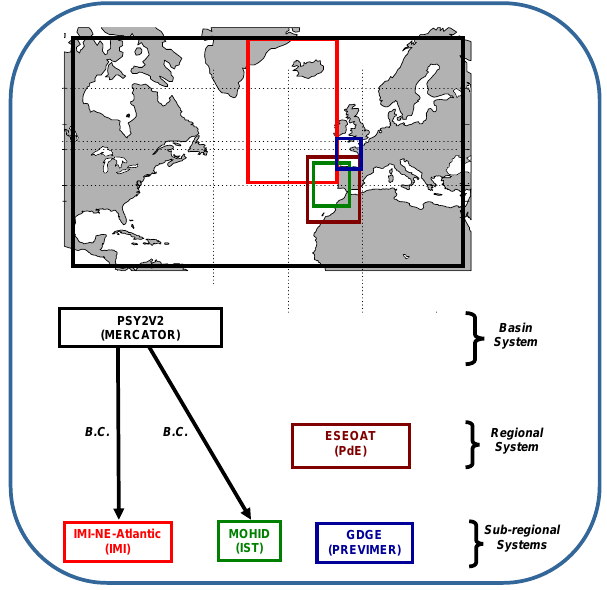
Figure 1: Downscalling scheme of integrated IBIROOS V0 (B.C. = Boundary Conditions) Fig. 1. Downscalling scheme of integrated IBIROOS V0 (B.C. = Boundary